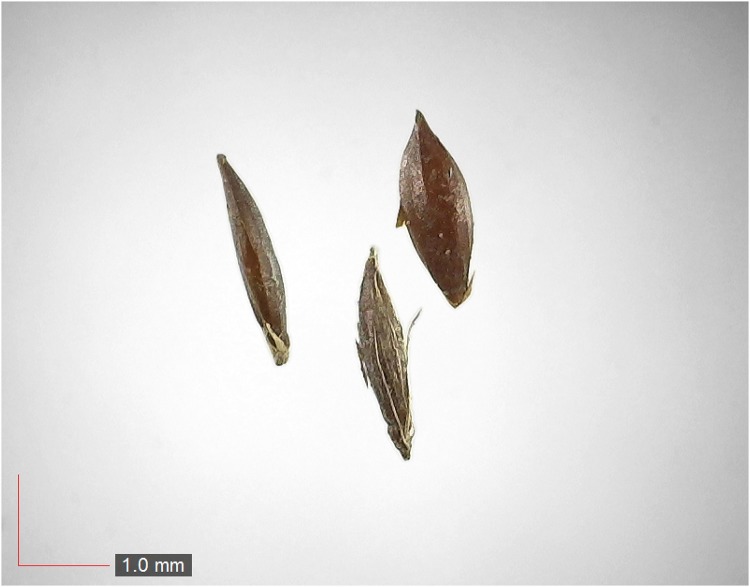
Unidentified 4 (probably Digitaria).Table 2.